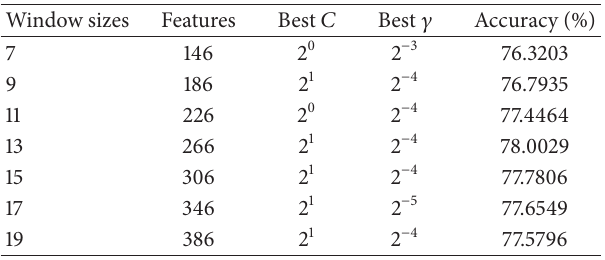
Table 6: Optimal parameters for different window sizes.